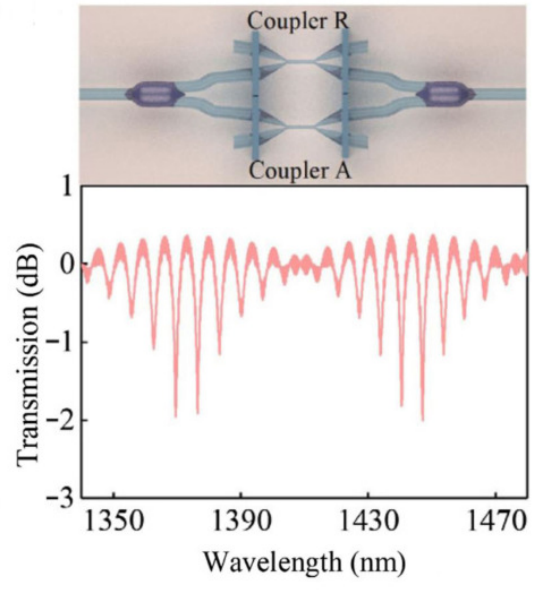
Figure 10. Microfiber couplers connected in parallel to produce the Vernier effect [68]. Reprinted with permission from Ref. [68] ©The Optical Society.